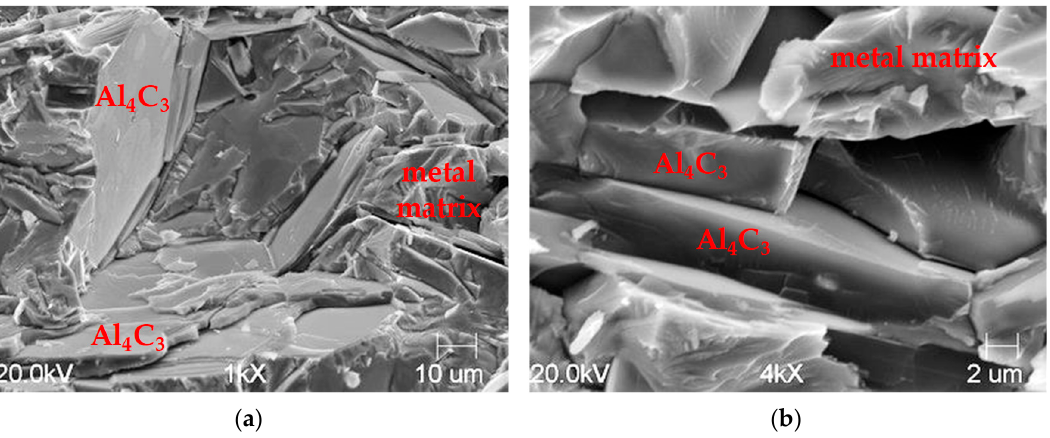
Figure 5. Microstructure of post-disintegration powder: different SEM microscope magnifications ( a , b ) and the site of EDS X-ray microanalysis ( b ).